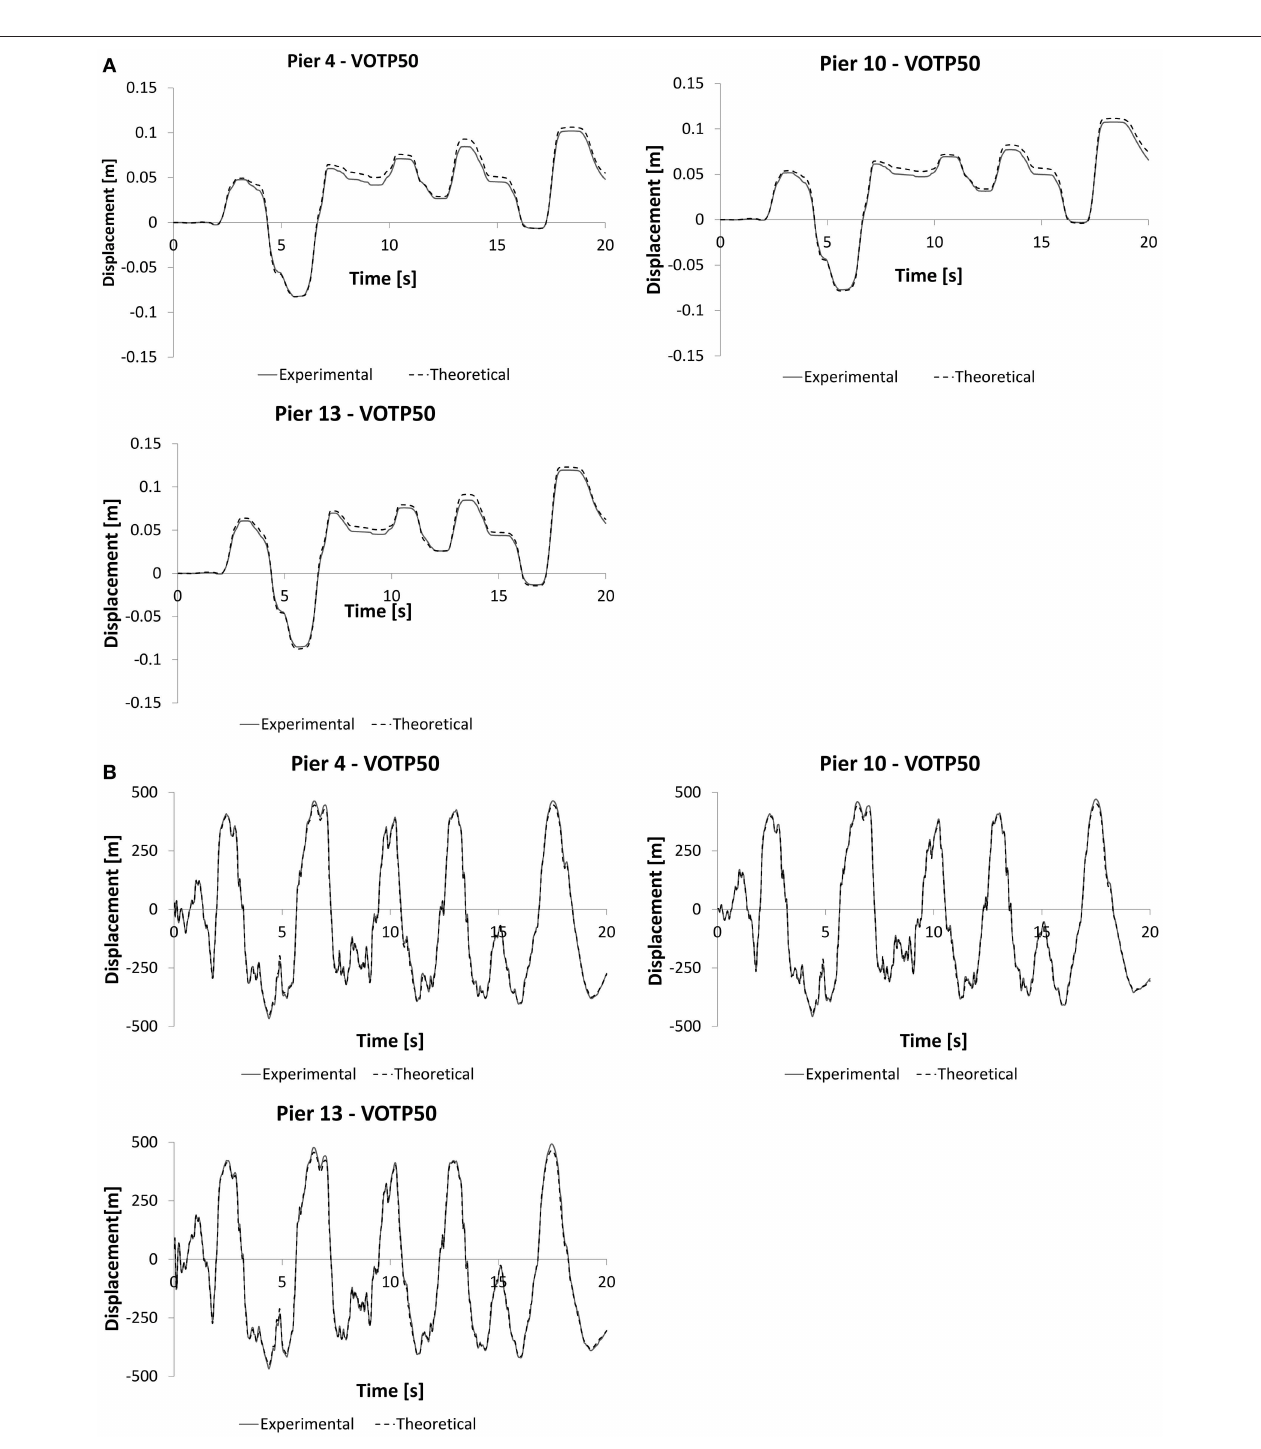
FIGURE 10 | Comparison between experimental and numerical results: (A) displacement vs. time curves between OTP and OTP devices; (B) force vs. time curves of the OTP and OTP devices.